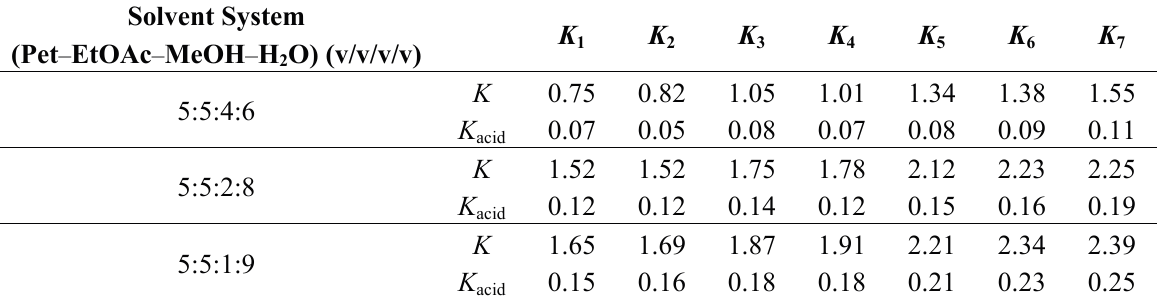
Table 1. The partition coefficient ( K ) values in both acidic and alkaline of different systems. Solvent